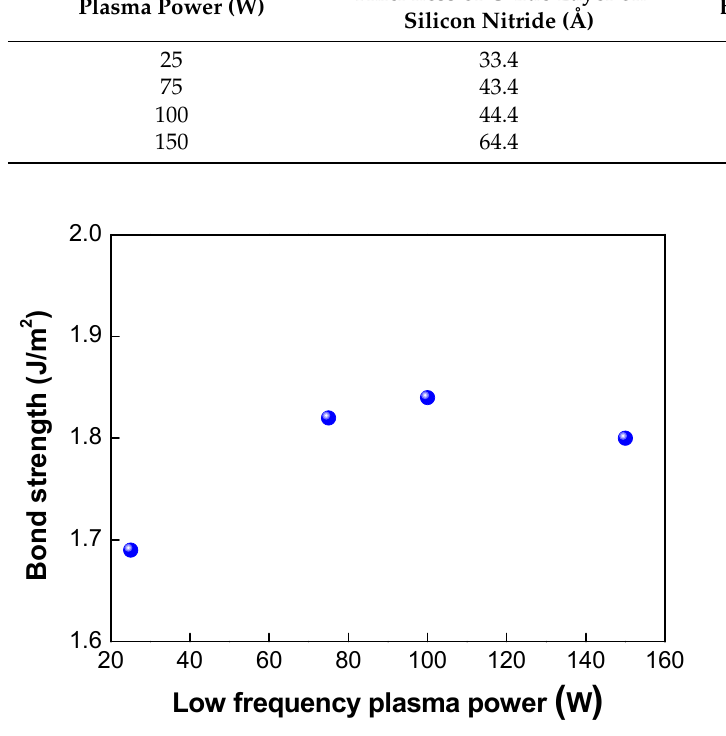
Figure 6. Changes in bonding strength when low frequency plasma power was increased.